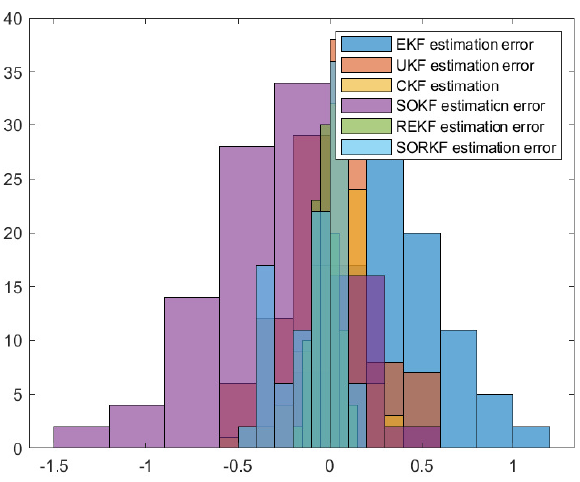
Figure 7. R2 estimation error of multi-robot in fixed formation. ( a ) X-Coordinate estimation error; ( b ) Y-Coordinate estimation error.